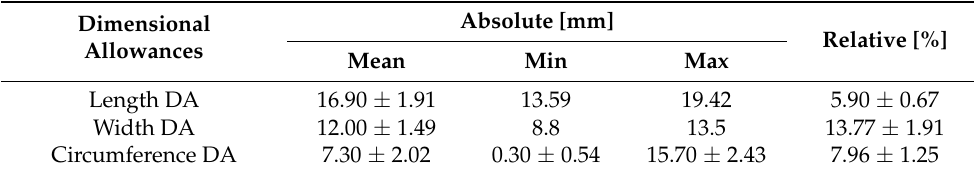
Table 4. Mean, minimun and maximum values of absolute and relative dimensional allowances (DAs) for gloved hand for three key hand anthropometric data: length, width and circumference. Dimensional Allowances